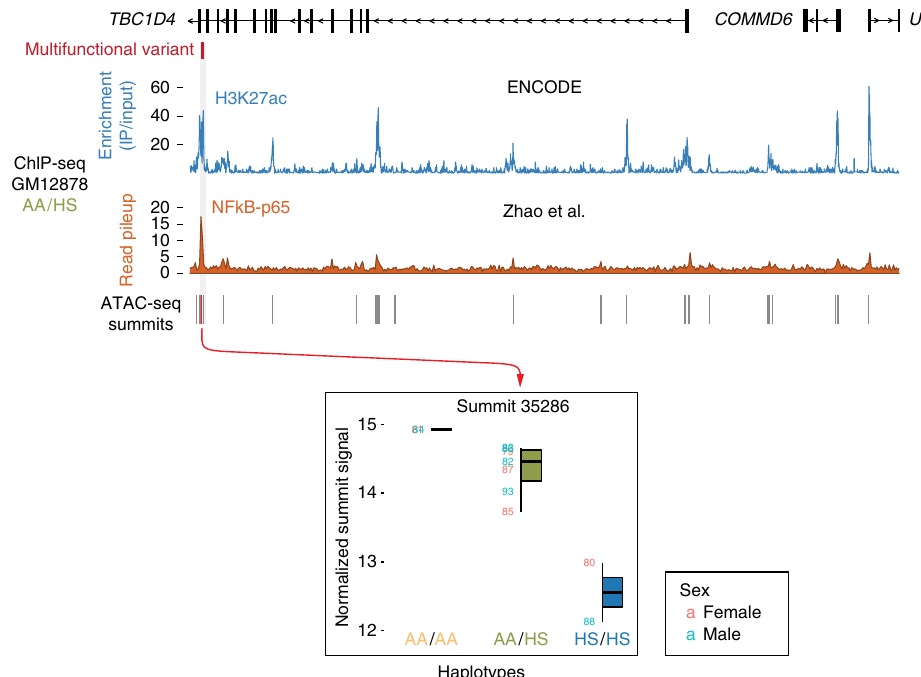
Fig. 5 Chromatin accessibility within the TBC1D4 multifunctional variant interaction domain. The intronic TBC1D4 cis -regulatory locus encodes a chromatin accessibility quantitative trait locus (caQTL) that is located at a site of strong ChIP-seq enrichment for H3K27ac and of read pileup for the p65 component of NF κ B, but is only signi fi cantly associated with the overlying ATAC-seq peak, with a higher normalized read count (summit signal) associated with the ancestral allele (AA) compared with the human-speci fi c (HS) allele. Boxplots represent the interquartile range (IQR) with the median denoted by the middle line; whiskers extend to the largest/smallest value no further than 1.5 times the IQR. Summit signal values are provided in a Source Data fi